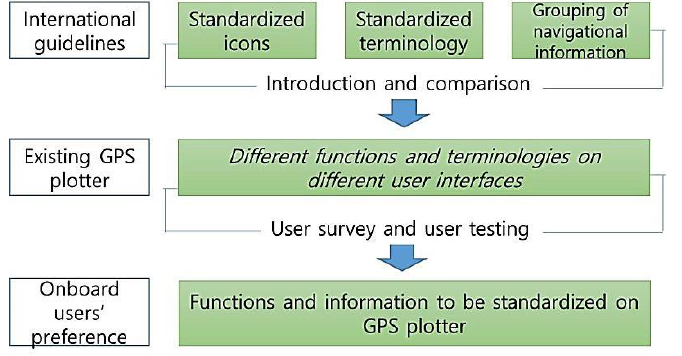
Figure 3. Concept of the methodology.